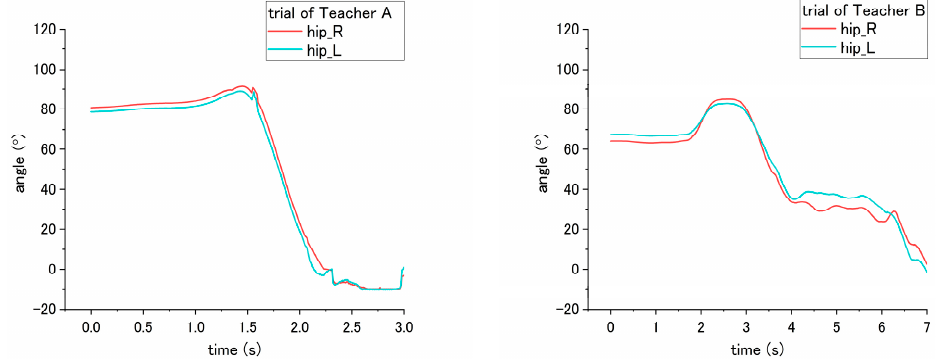
Figure 16. Flexion angle of patient’s hip during step No. 11 when the incorrect way was conducted at step No. 5-(2).